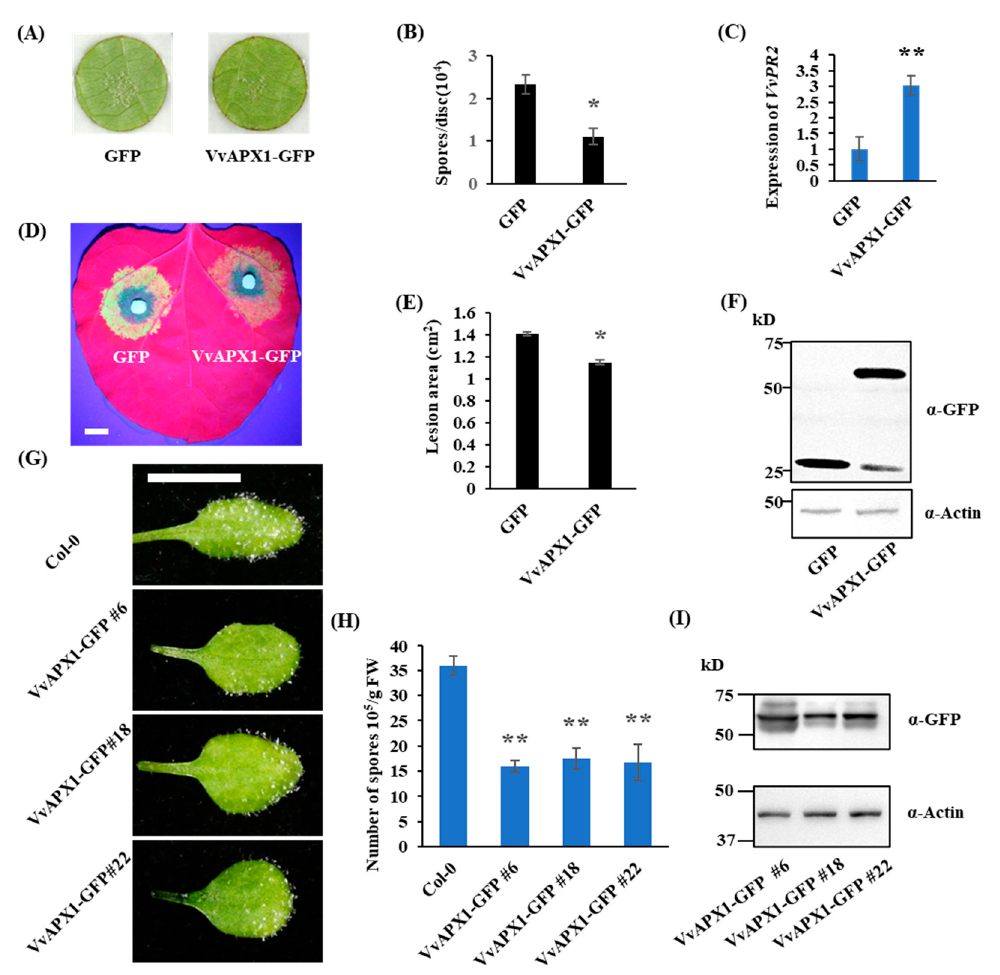
Figure 4. VvAPX1 positively regulate plant immunity. ( A , B ) P. viticola was inoculated at 4 days after agroinfiltration. Count of spores and photo were taken at 7 dpi. ( C ) Expression level of pathogen- related gene PR2 was determined at 3 dpi. ( D ) P. capsici was inoculated onto N. benthamiana leaves at 24 h after agroinfiltration. Photo was taken at 60 hpi under UV. Scale bar = 1 cm. ( E ) Lesion area of each construct. Data are shown as the mean ± SD ( n = 6). ( F ) Western blot of protein level of VvAPX1 in N. benthamiana with anti-GFP antibody, at 2 days after agroinfiltration. ( G , H ) Two-week-old Arabidopsis were inoculated with H. arabidopsidis . Photo was taken at 4 dpi. Scale bar = 0.5 cm. Spores were counted at 4 dpi. ( I ) Western blot of protein level of VvAPX1 in transgenic Arabidopsis with anti-GFP antibody. * represents significant difference ( p < 0.05, Student’s t test). ** represents extremely significant difference ( p < 0.01, Student’s t test).